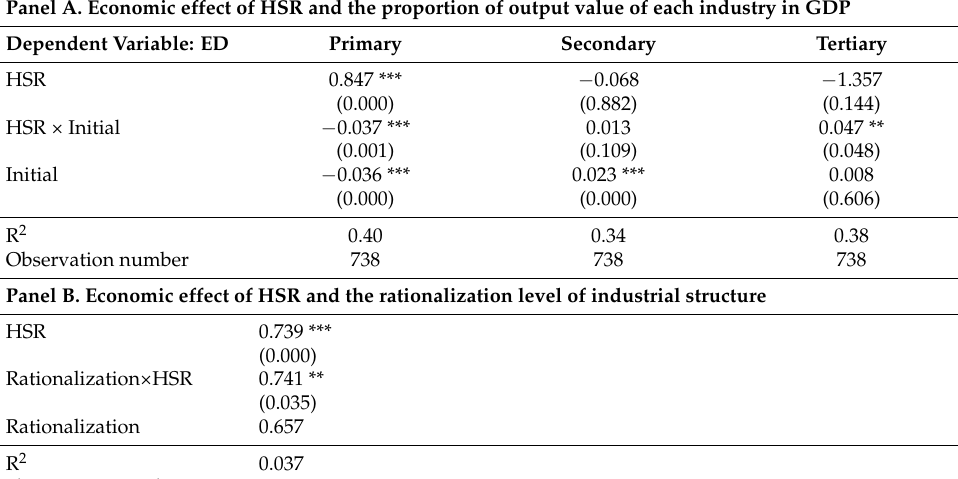
Table 4. Economic effect of HSR and industrial